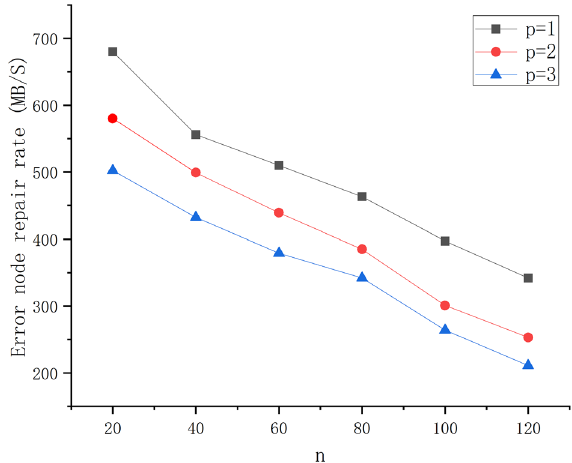
Figure 5. Error node repair rate.